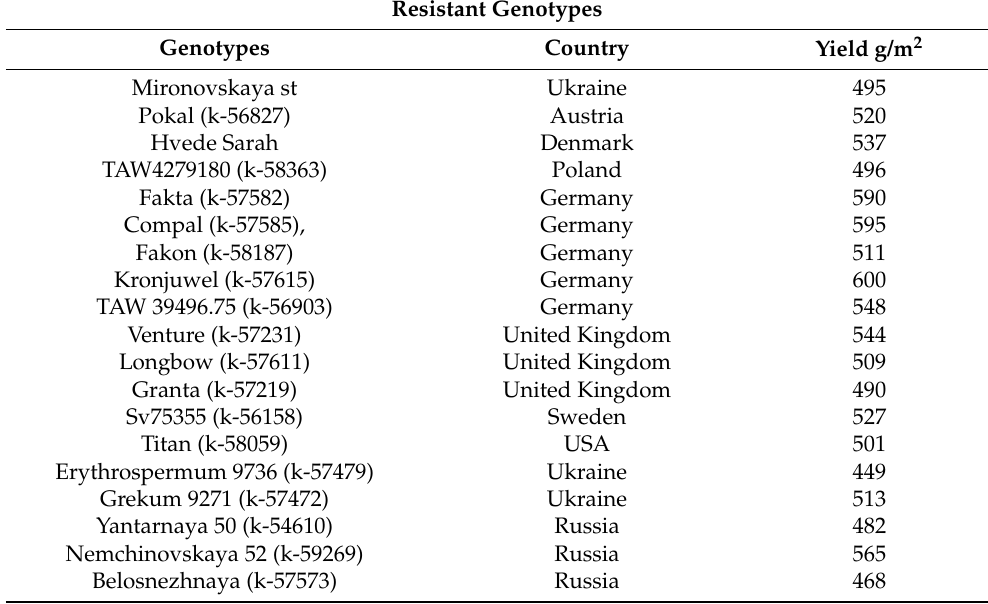
Table 3. Yield of the resistant genotypes